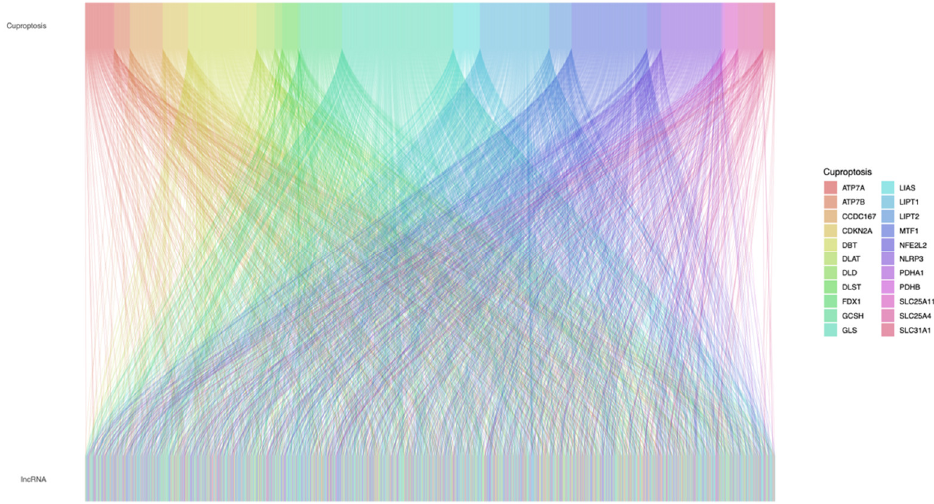
Figure 1. The relationships between cuproptosis-related genes and cuproptosis-related lncRNAs in the Sankey diagram. lncRNA, long noncoding RNA.